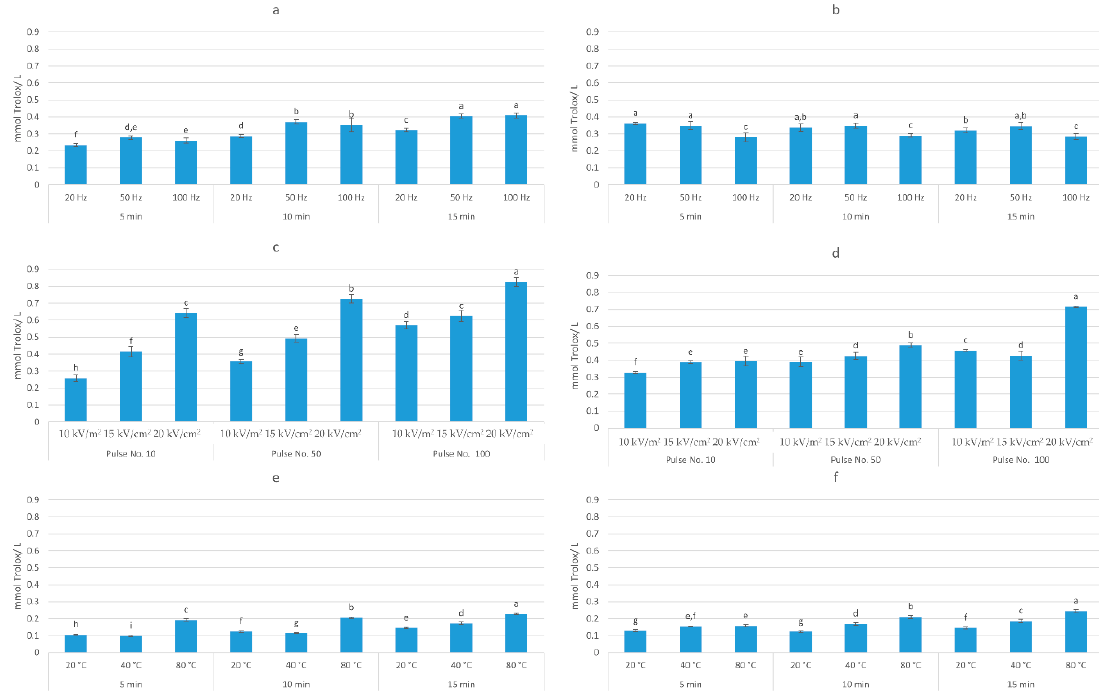
Figure 4. Antioxidant activity (mmol TE / g dw) of: ( a ) HVED ethanol-based extracts; ( b ) HVED methanol-based extracts; ( c ) PEF ethanol-based extracts; ( d ) PEF methanol-based extracts; ( e ) UAE ethanol-based extracts; ( f ) UAE methanol-based extracts. Bars with different letters are significantly different ( p < 0.05).